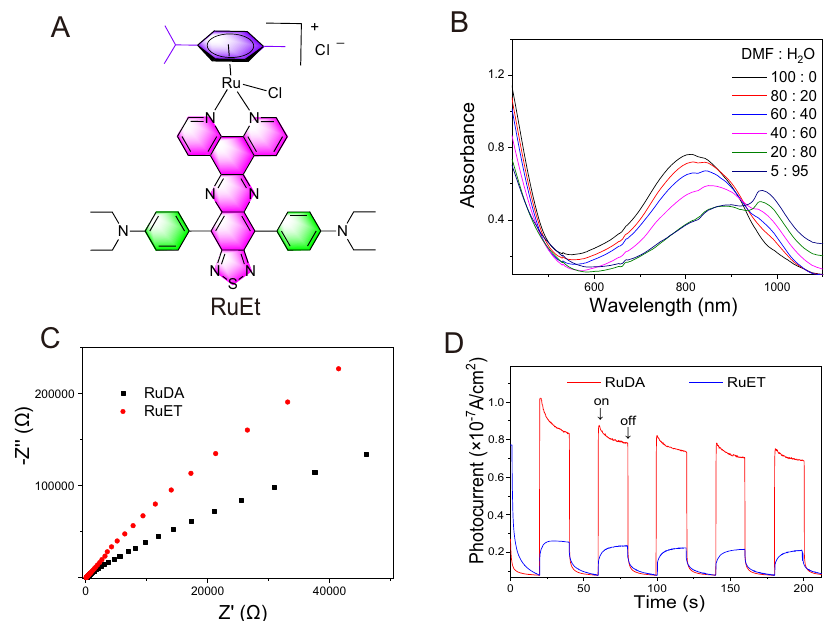
Fig. 4 Photoelectrochemical properties of RuDA and RuET. A Chemical structure of RuET. B Absorption spectra of RuET in mixtures of DMF and water at various ratios. C EIS Nyquist plots of RuDA and RuET. D Photocurrent responses of RuDA and RuET under 808 nm laser irradiation.